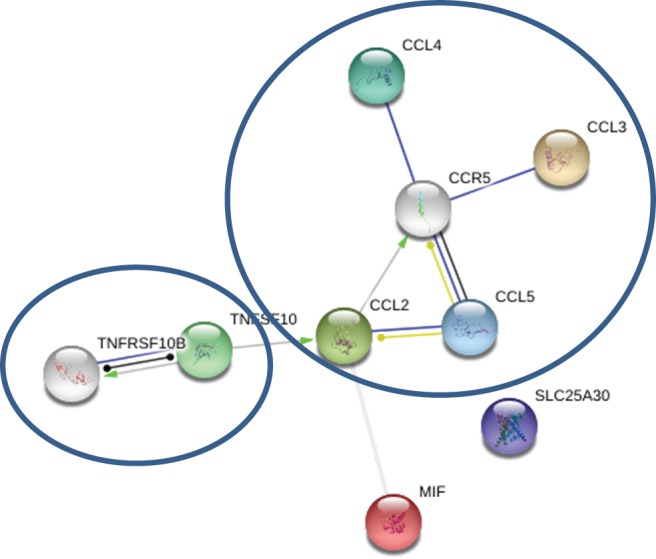
Serum STRING analysis: green—activation; blue—binding; black—reaction; yellow—expression; white dots are introduced nodes; thicker the line = stronger interaction; STRING 9.0 (http://string90.embl.de/) high confidence 0.7 (circled are clusters k-means 3).